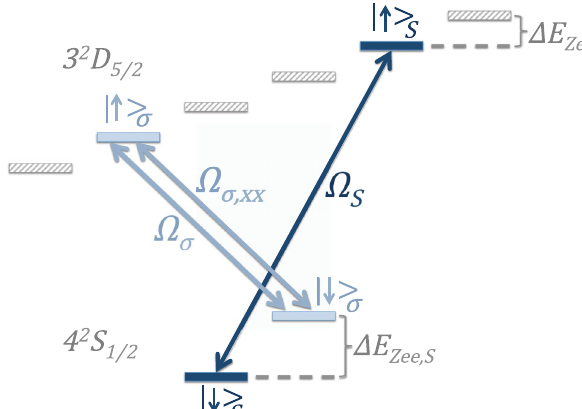
FIG. 4. Schematic-level diagram of a single ion summarizing the applied spin-phonon couplings (sketched for optical quadru- pole qubits as in 40 Ca þ ). The processes in Figs. 3(b) and 3(c) and S z to radial phonon modes. The correct weight couple (cid:5) z i i;i þ 1 of zz interactions for the Gauss law requires effective coupling j ¼ 8 j (cid:3) j . The xx interactions in H may be strengths j (cid:3) S (cid:5) K generated by Mølmer-Sørensen–type couplings of strength . Coupling to undesired internal levels is avoided by (cid:3) (cid:5);xx selection rules and Zeeman splittings (cid:2) E . Whether the Zee ;D=S ion represents an S or a (cid:5) spin is determined by its initialization in the state j #i or j #i S (cid:5)